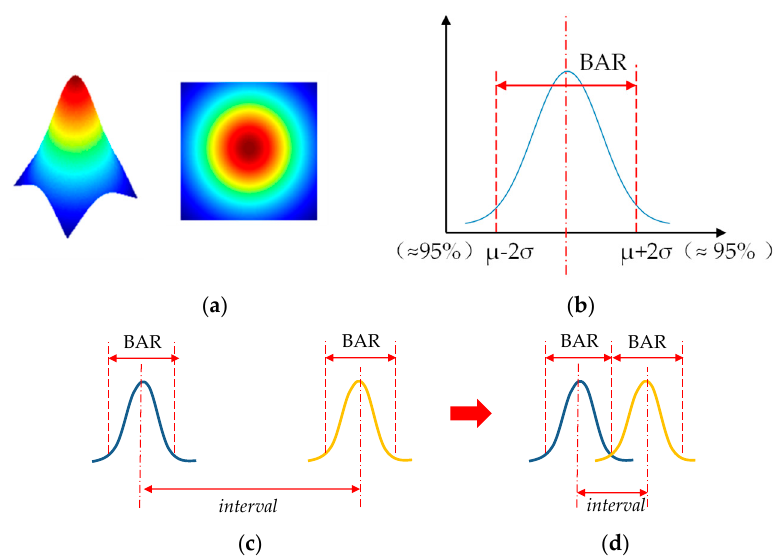
Figure 2. Definitions of the brightness attenuation range (BAR) and interval of projected dots: ( a ) brightness distribution of optical dots, ( b ) definition of the BAR, ( c ) definition of the interval between two adjacent dots, and ( d ) optimal interval.